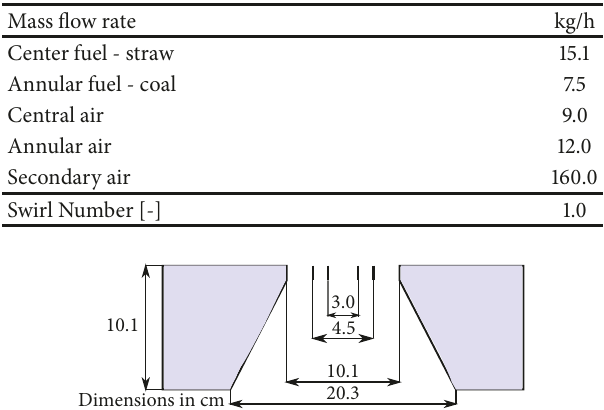
Table 1: Operating conditions of the targeted test case [5].